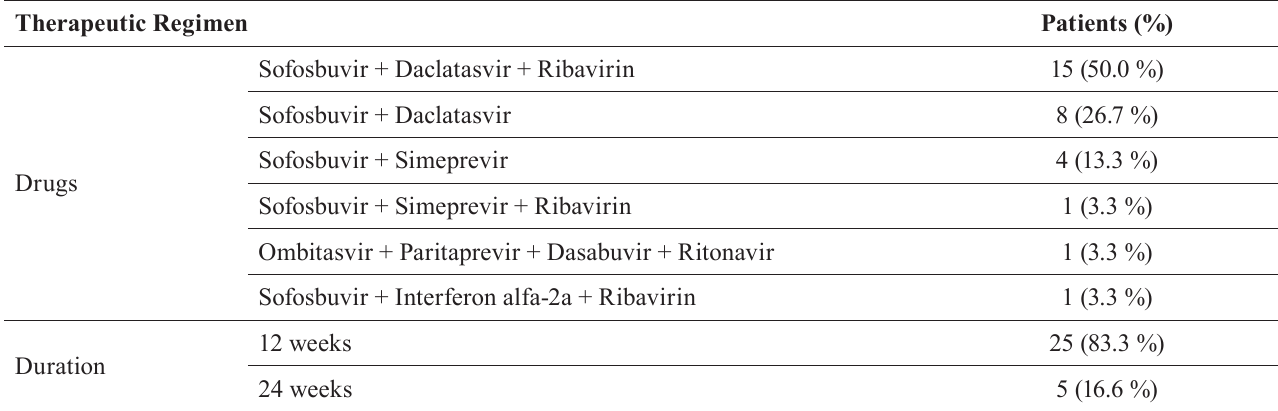
TABLE I – P rescribed therapeutic regimens for Hepatitis C treatment of patients attended by the Specialized Pharmacy of Londrina between June 2017 and June 2018 (N =